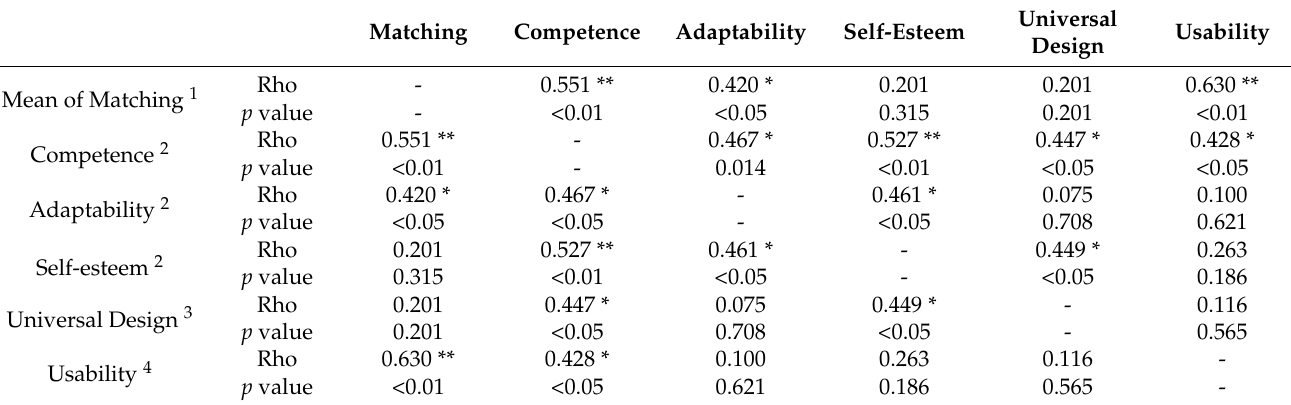
Table 4. Significant correlations between quantitative